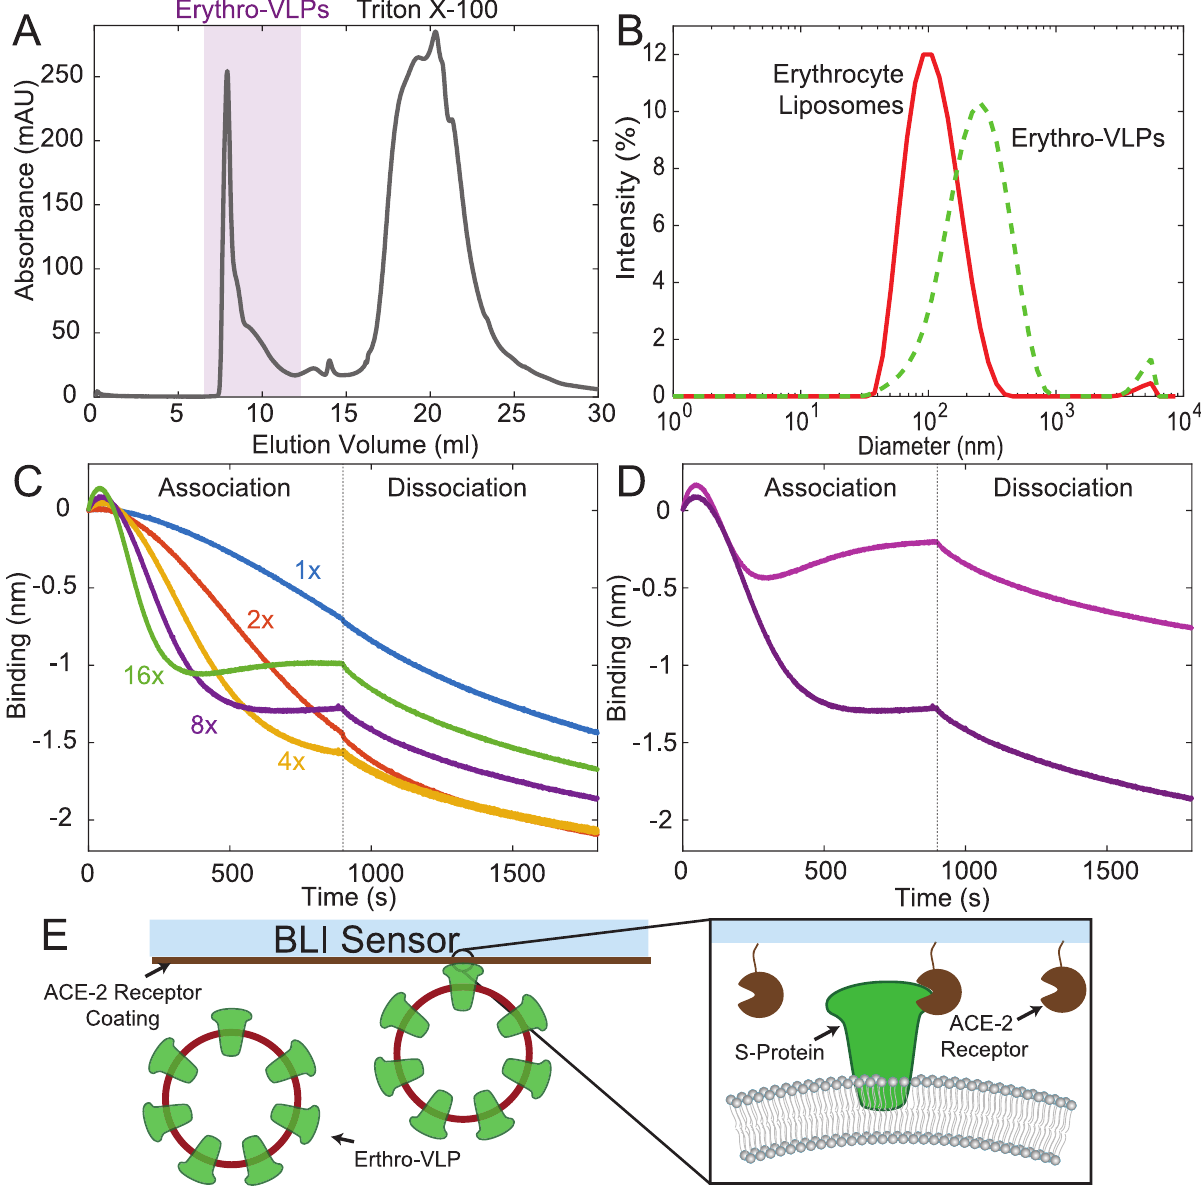
Fig 2. A : Size exclusion chromatogram of the Erythro-VLPs showing two signals from Erythro-VLPs and Triton-X100. B : Size distribution of Erythro- VLPs, as determined by DLS. While erythrocyte liposomes measured 102 nm (polydispersity: 0.19) an average diameter of 222 nm (polydispersity: 0.32) was determined for the S-protein carrying liposomes. C : Binding of Erythro-VLPs to human ACE-2 protein was measured by biolayer interferometry (BLI). A dose-dependent reduction in BLI signal was observed upon exposure of the ACE-2 immobilized biosensors to increasing concentrations of Erythro-VLPs, consistent with the binding of large particles to the optical biosensor. D : Association and dissociation curves for Erythro-VLPs in the absence (light purple) and presence (dark purple) of human ACE-2 immobilized onto the biosensor. The dark purple curve is reproduced from C (8 × ) for the purpose of comparison. E : Schematic of the BLI. Biotinylated human ACE-2 was immobilized onto the Streptavidin BLI sensor. The sensor was then exposed to Erythro-VLPs and association and dissociation was